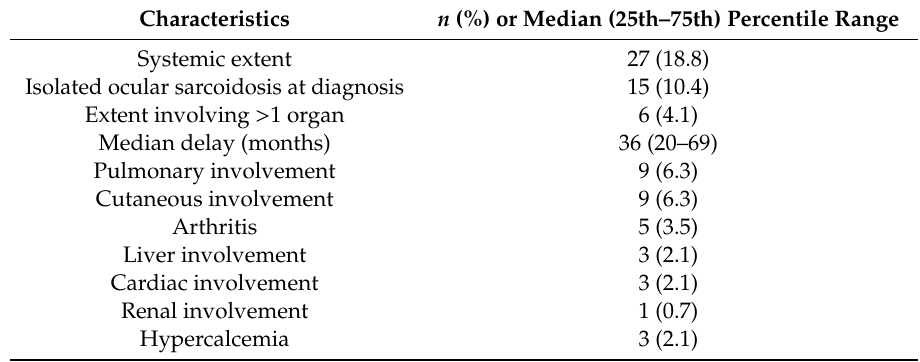
Table 3. Extent of the sarcoidosis during follow-up of the 143 patients with sarcoid uveitis. Characteristics